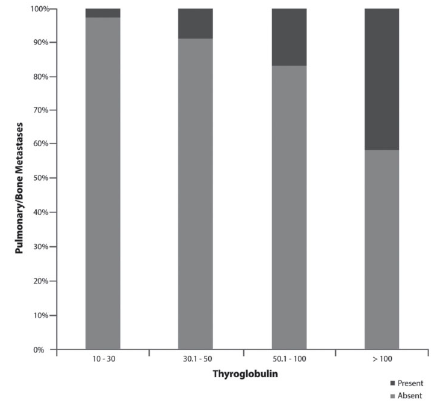
Figure 2. Distribution of distant pulmonary and bone metastases according to thyroglobulin levels. P o 0.05 between present and absent at all thyroglobulin levels (chi-squared test).